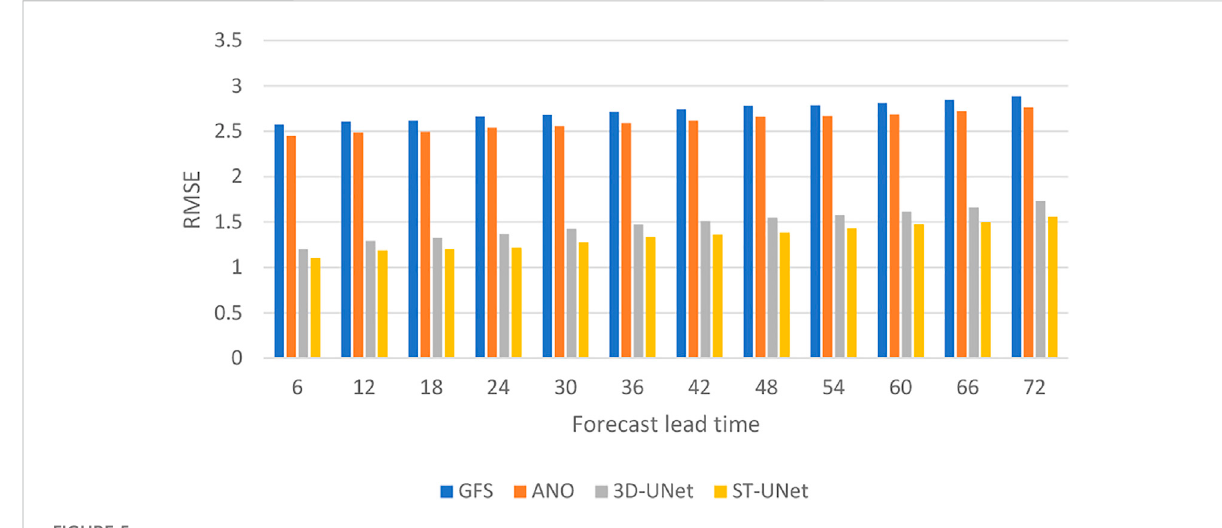
FIGURE 5 The RMSE of bias correction on the 2-m temperature for different forecast times on the test